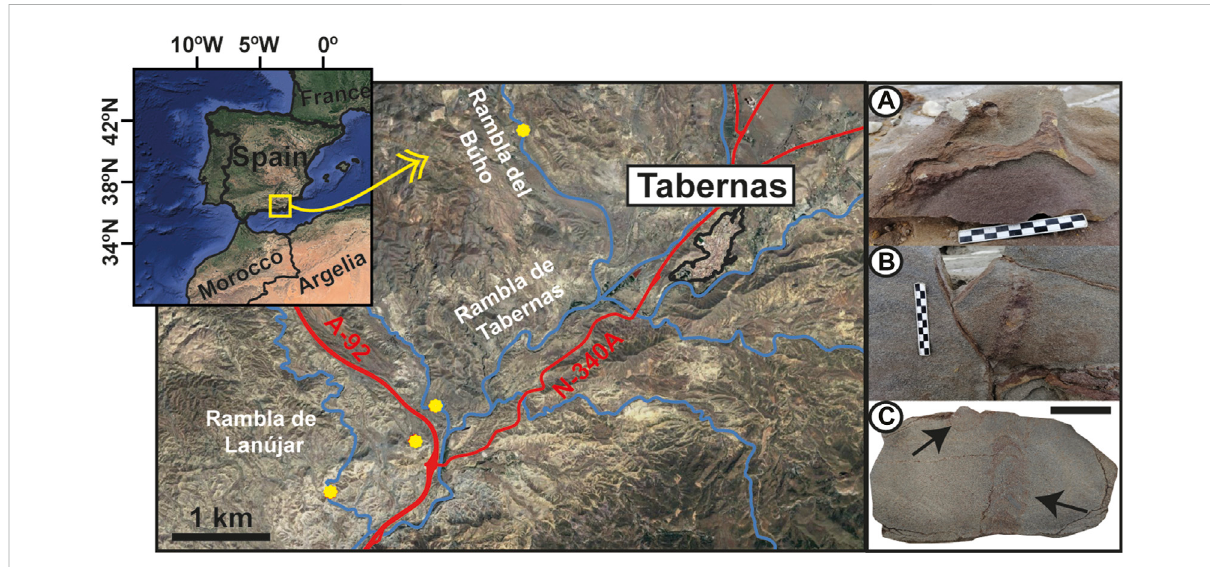
FIGURE 1 Location of the study area (sampled outcrops = yellow points). (A,B) Outcrop examples of Ophiomorpha specimens. (C) Polished section with Ophiomorpha specimens (black arrows) (specimen Op-7), scale bar = 2